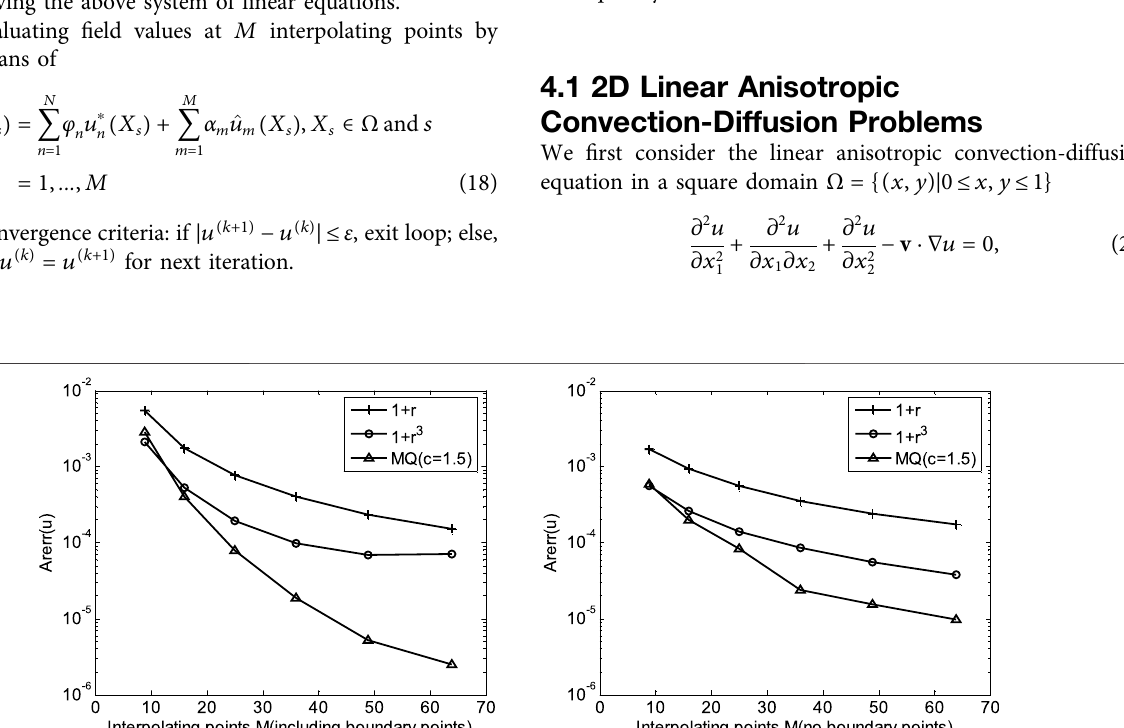
Frontiers in Physics |